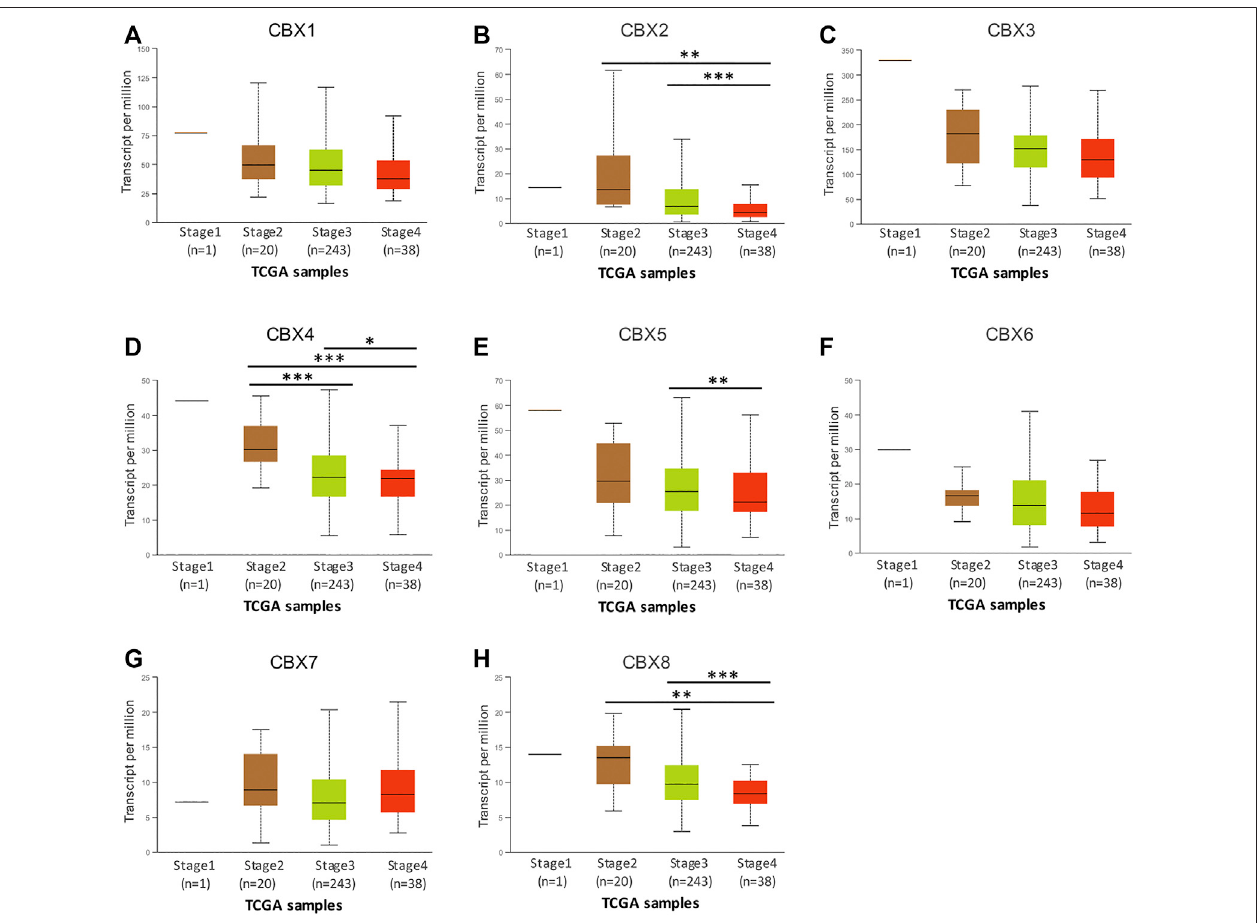
FIGURE 3 | The relationship between the mRNA expression levels of different CBXs members and individual cancer stages in patients with OV. (A – H) The relationship information of CBX1-8 was evaluated from the UALCAN database. * p < 0.05, ** p < 0.01, *** p < 0.001.